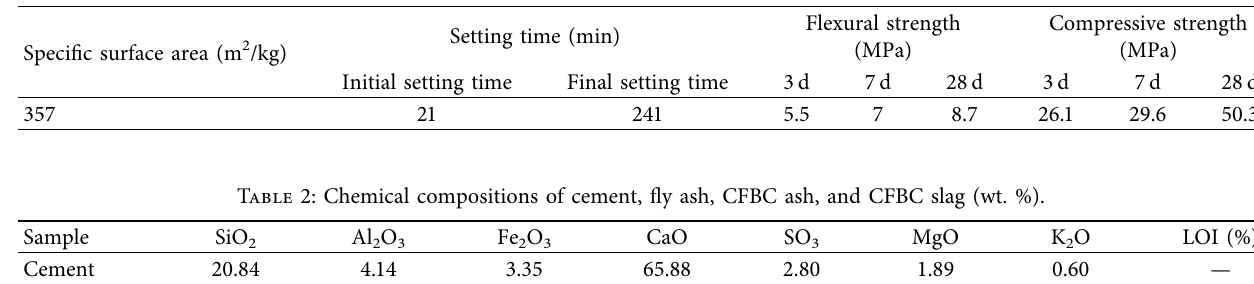
Table 1: Physical properties of the portland cement.